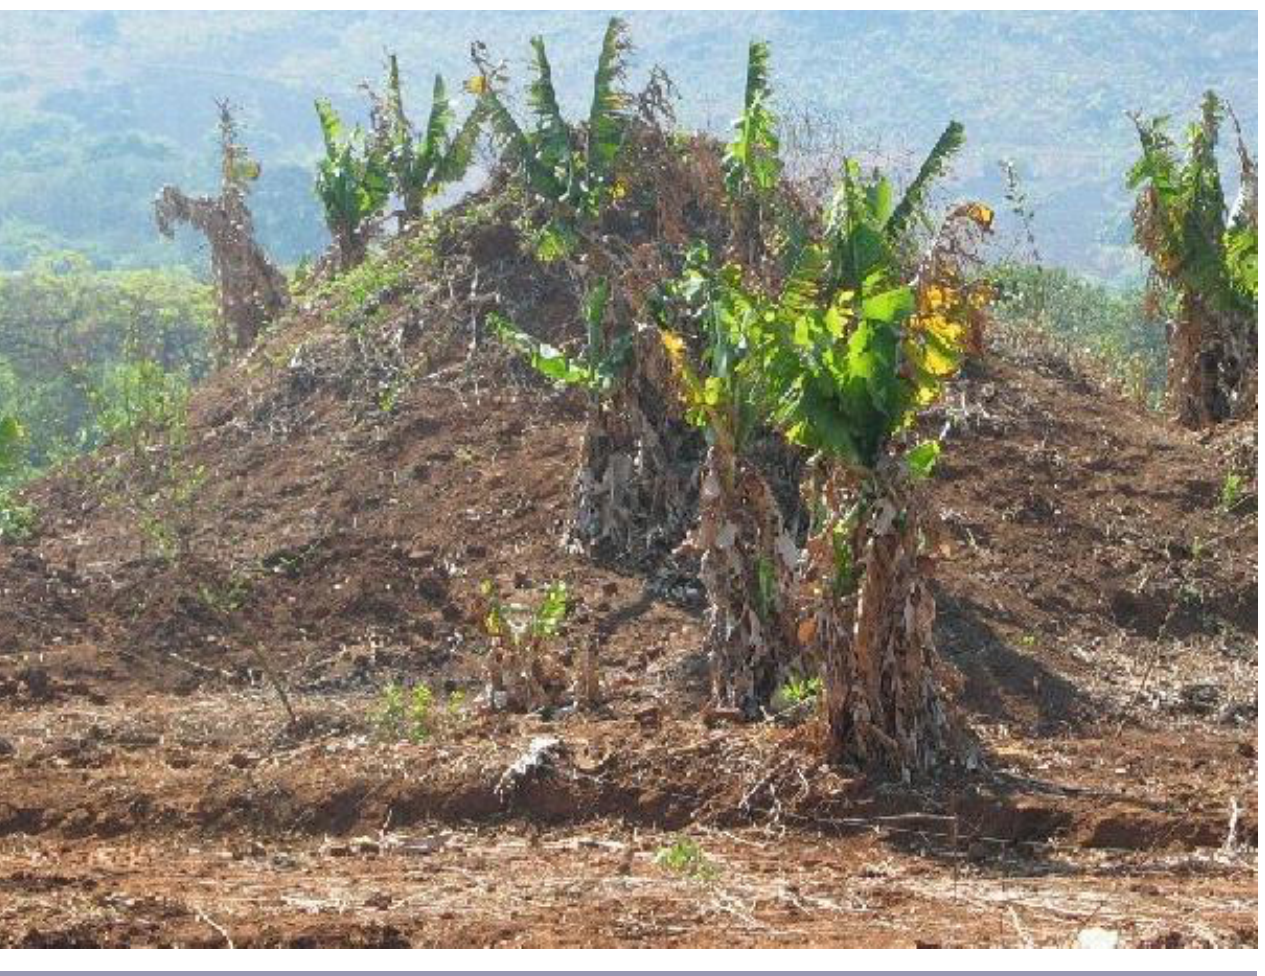
Fig. 2. Farmers’ practice of planting crops around termitaria. This farmer in Zomba district of southern Malawi has planted banana and pigeon pea on an Odentotermes